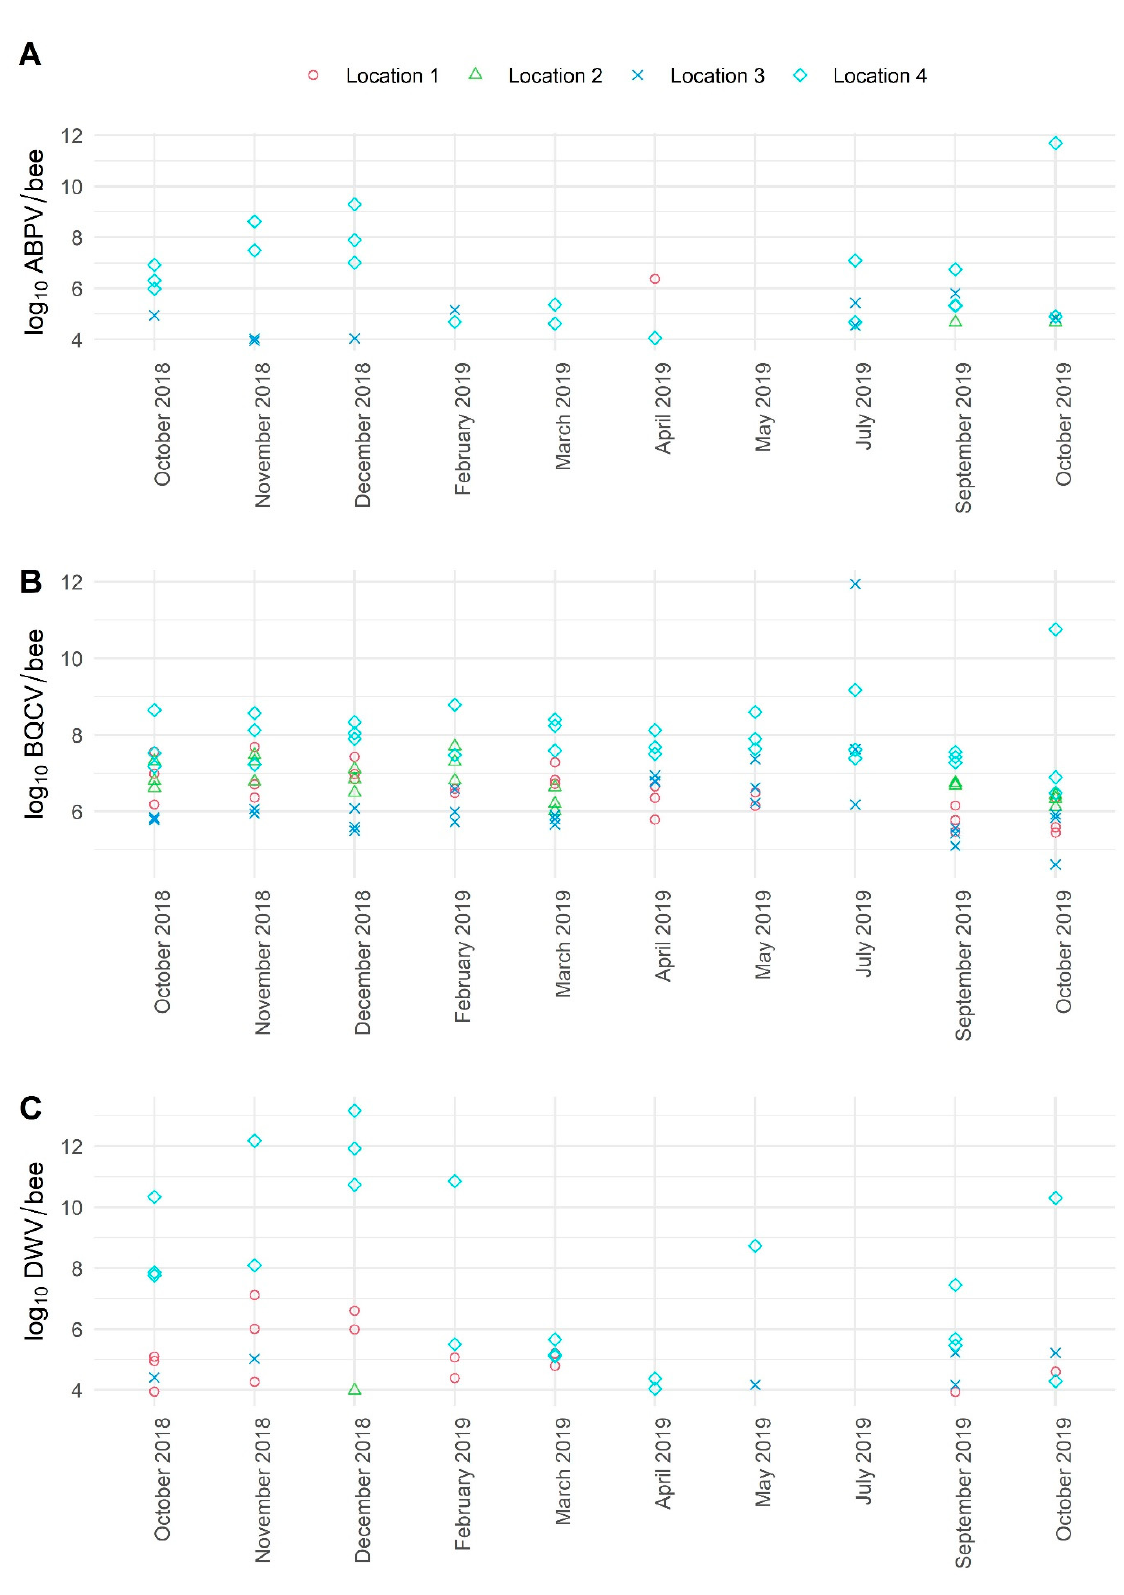
Figure 4. The detected average viral loads of positive samples for ABPV ( A ) (no. of samples: 109, no. of positive samples: 32), BQCV ( B ) (no. of samples: 109, no. of positive samples: 106), and DWV ( C ) (no. of samples: 109, no. of positive samples: 43) of healthy adult honeybees during the 10 months of sampling. One symbol represents one positive honeybee sample consisting of 10 honeybees.